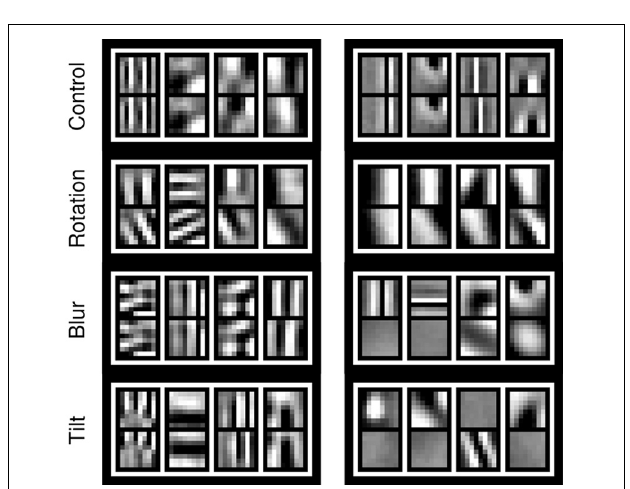
FIGURE 6 | Example basis functions that emerge at the end of training (100,000 iterations) for coarse (left column) and fine scale (right column). Each row corresponds to a different perturbation (Roll of 25 ◦ ; Blur of σ = 4 px; Tilt of 2 ◦ ). The pan perturbation case is not considered, as it does not induce any significant change in left and right part of the bases as compared to the control case. See also the video available online for the roll perturbation (Lonini et al.,